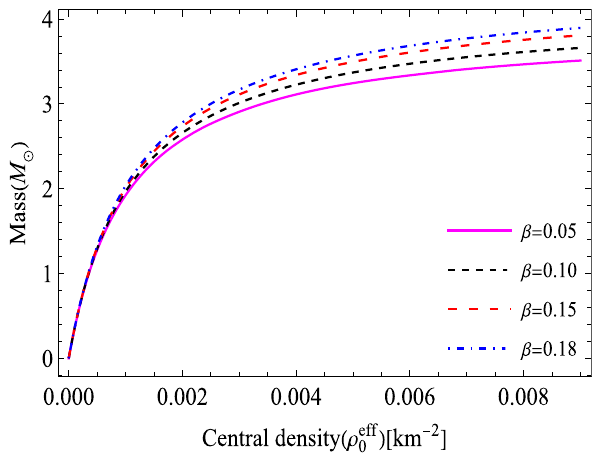
Fig. 8 Theabovefigureshowthebehaviorofthemass( M / M (cid:9) )versus central density ( ρ eff ) for different β 0